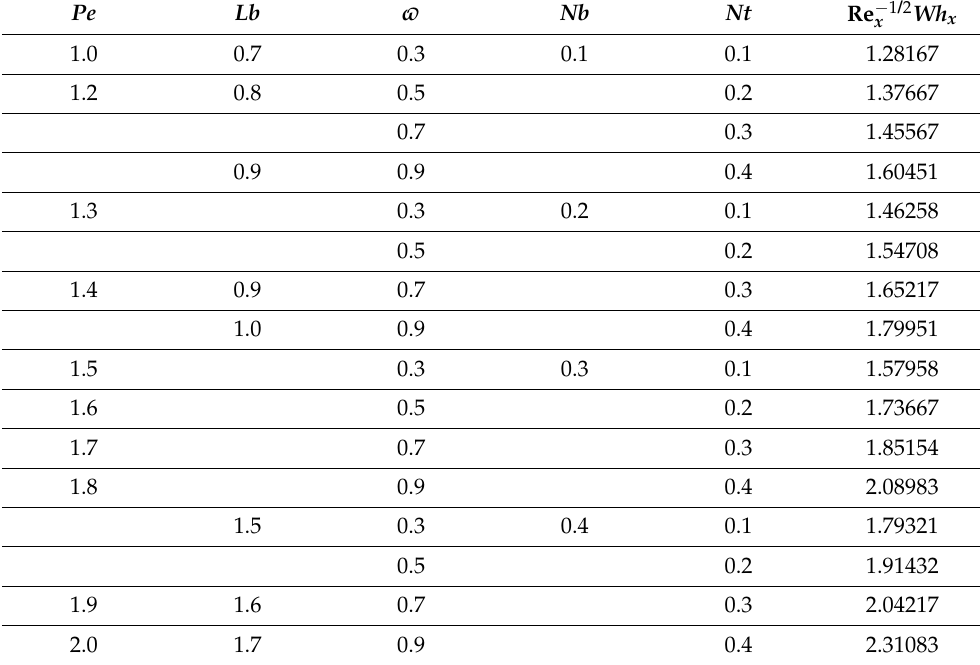
Table 6. Numerical outcomes Re − 1/2 x Wh x for numerous values of Pe , Lb , (cid:118) .